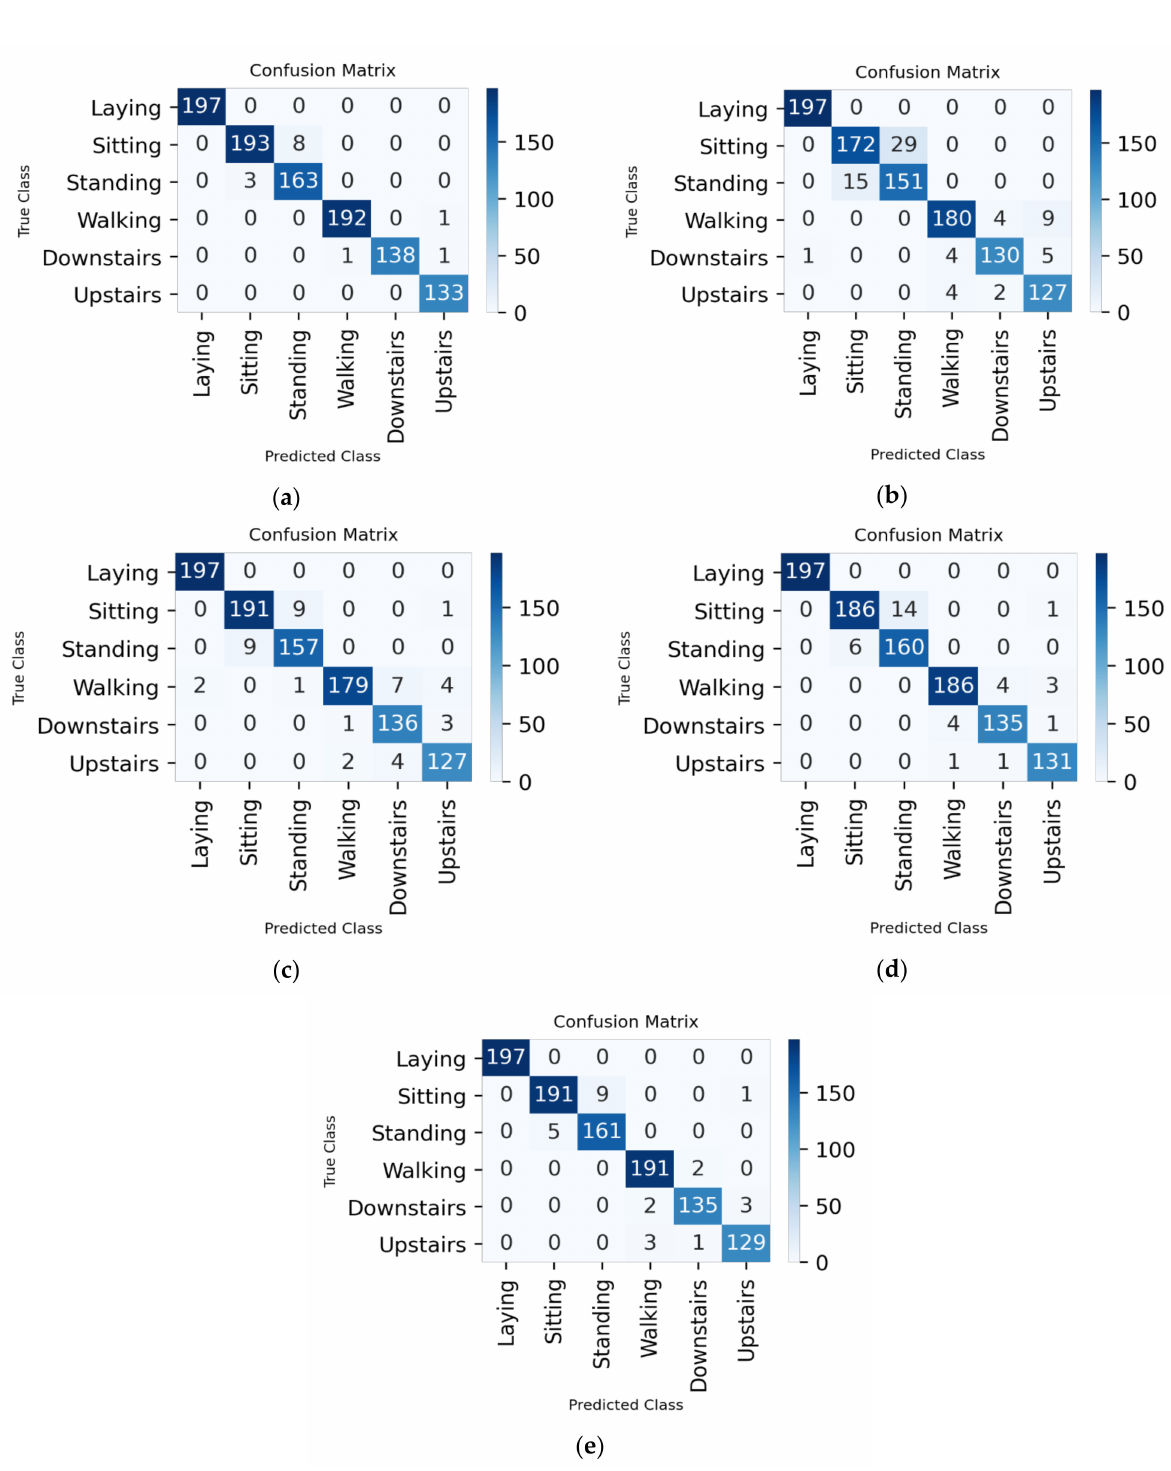
Figure A2. Confusion matrix for 80–10–10% split ratio: ( a ) all the features; ( b ) 48 features; ( c ) 92 features; ( d ) 138 features; and ( e ) 164